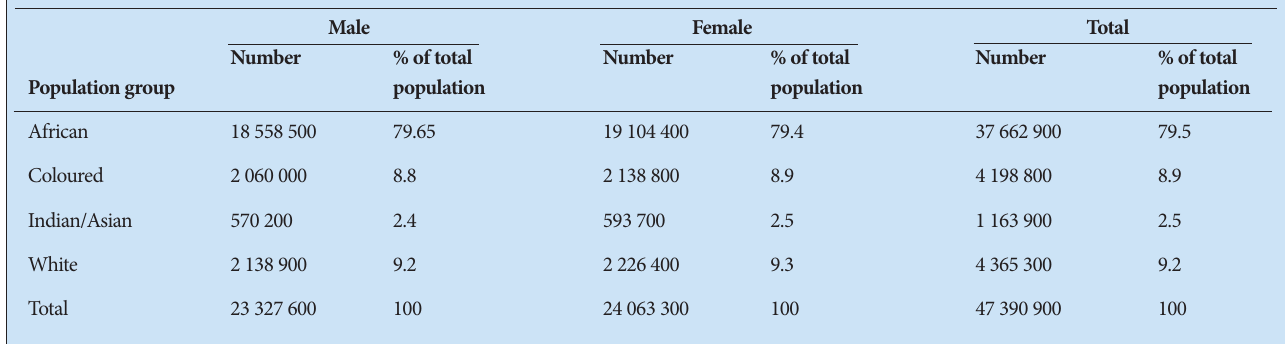
Table II. Mid-year estimates for South Africa by population group and sex,